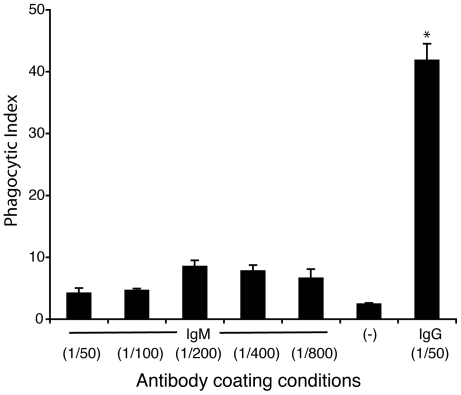
IgG, but not IgM, drastically enhances the uptake of sRBCs by macrophages.Light microscopy analyses show that macrophages effectively phagocytose IgG-coated sRBCs (∼7–10 µm) compared to control sRBC with no coating antibody (p<0.05). IgM-coated sRBCs are not effectively taken up by the macrophages. Although IgM coating conditions shows a small dose-dependence at low concentrations of the antibody, this effect is less likely to represent a biologically significant effect. Phagocytic index represents the number of sRBCs internalized by 100 macrophages. Antibody dilutions used for coating sRBCs are shown within parenthesis. Data are representative of 3 experiments performed on different days with similar results. Error bars are ± SEM from 3 technical replicates.